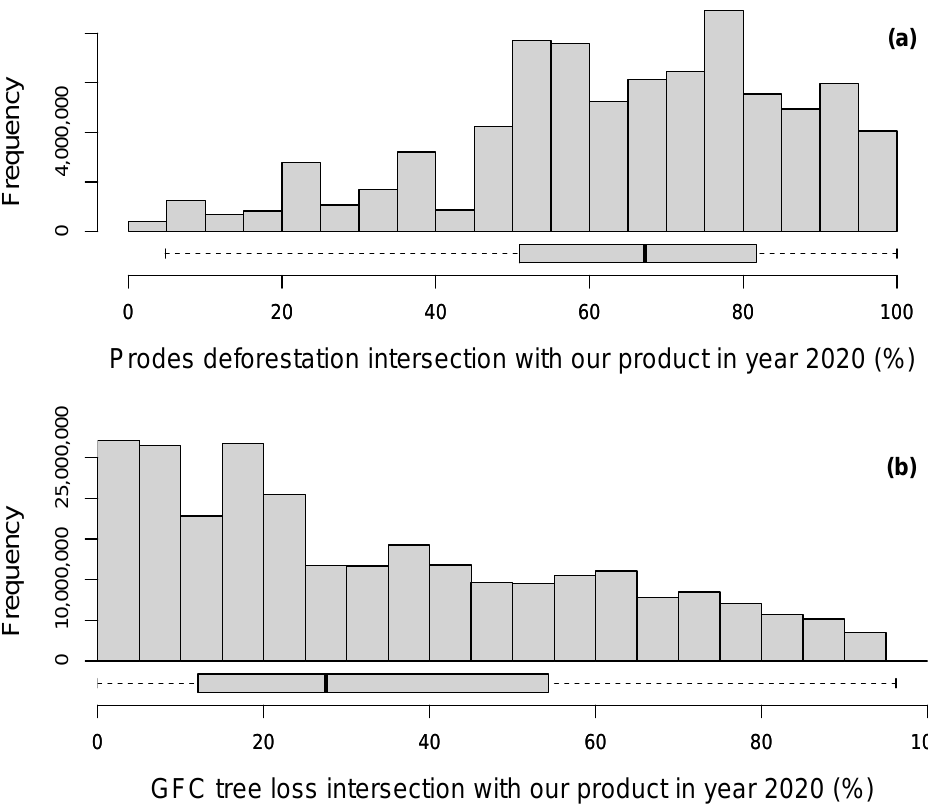
Figure 6. Histogram of intersection per planet tiles of our product of deforestation with the PRODES data ( a ) and GFC tree cover loss ( b ) per quad for the year 2020. Each intersection value was weighed by the number of pixels with intersection observed in the tile, of PRODES or of GFC “tree loss year data”. The boxplot of the distribution of intersection is presented below each histogram for the visualization of median and